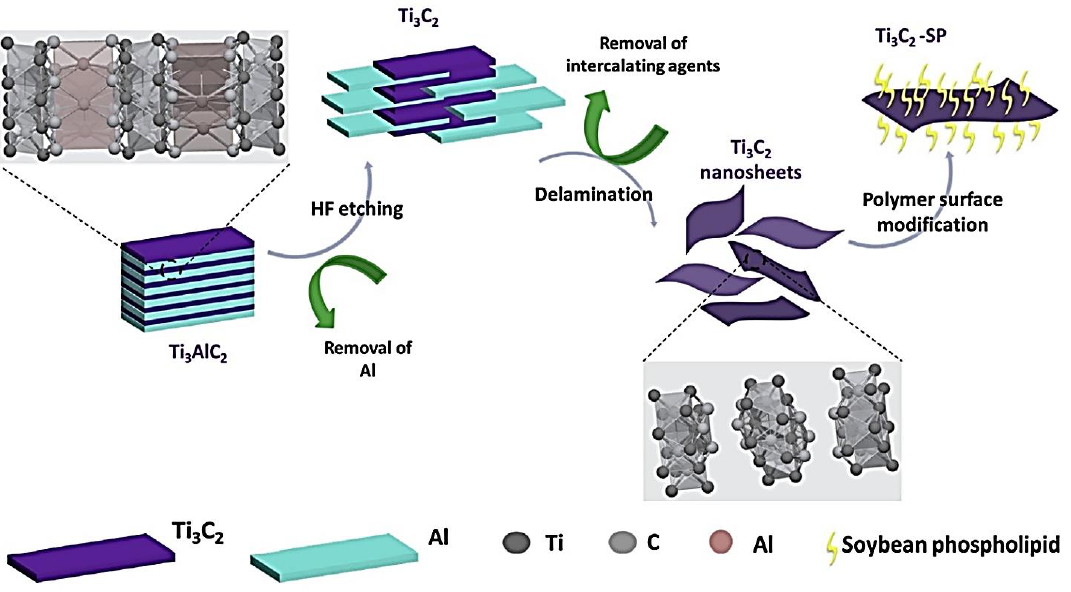
Figure 3. Synthesis cycle of Ti3C2 ‐ SP nanocomposite [11]. Reprinted with permission from Ceramics International. © 2019 Elsevier Ltd. and Techna Group S.r.l.